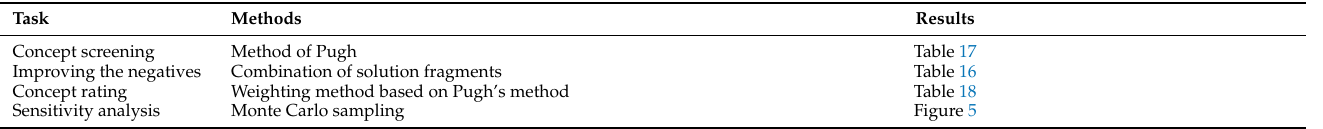
Table 19. Summary of tasks and methods adopted in the Concept selection